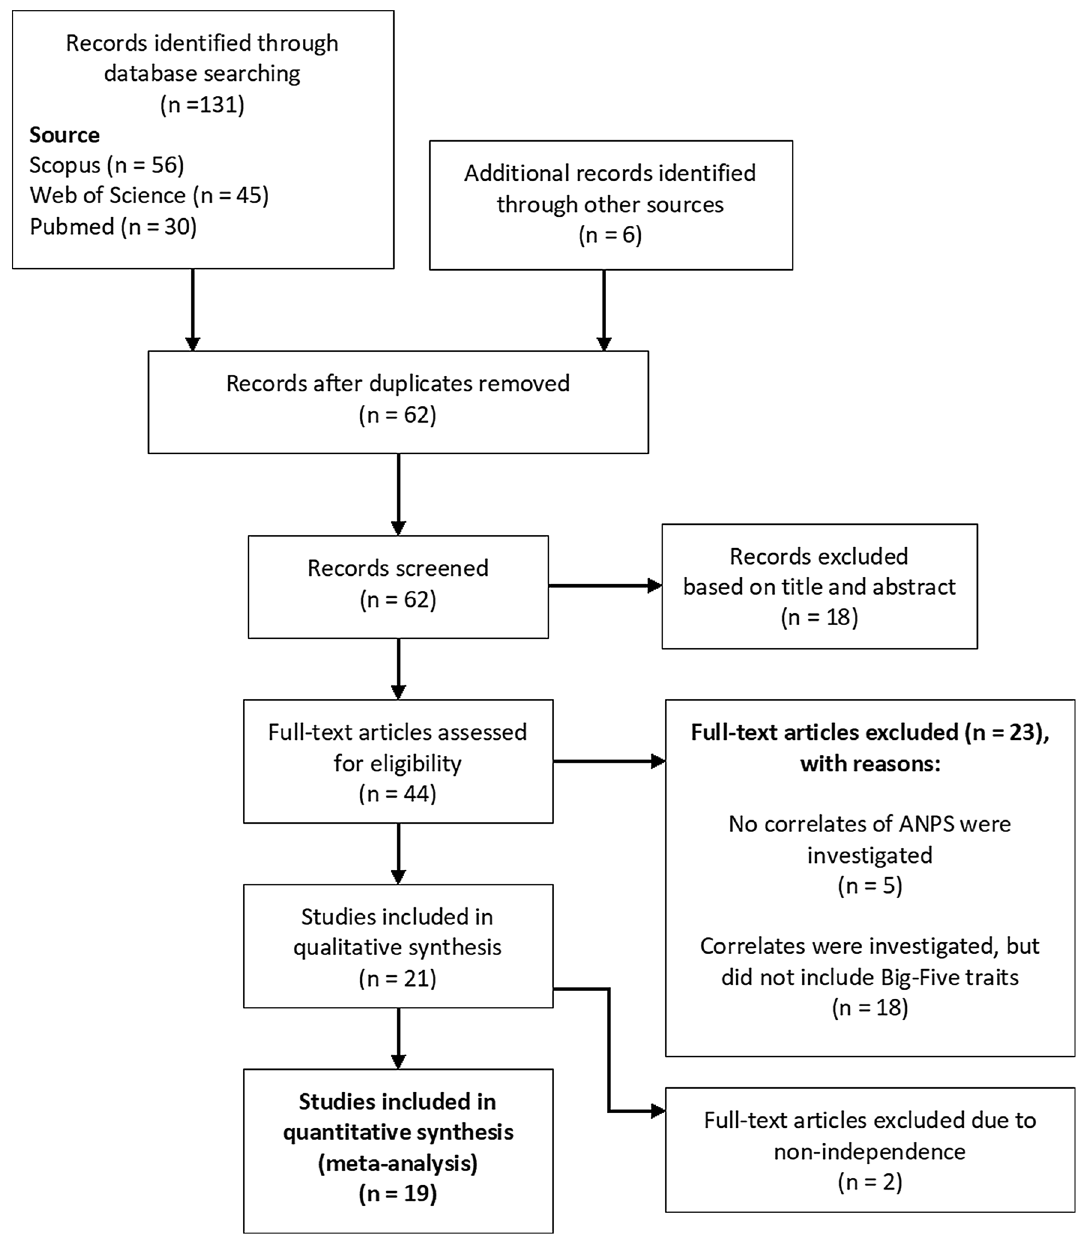
Figure 1. Flow chart of study